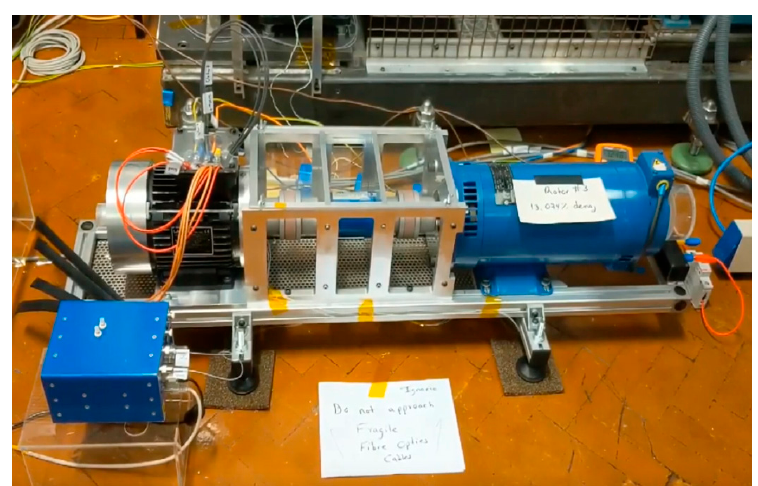
Figure 3. Test-rig setup scheme.